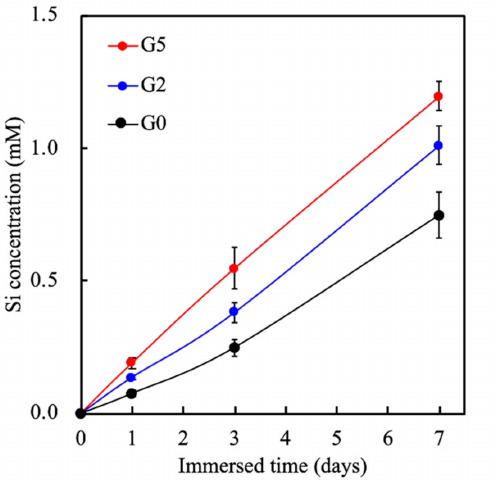
Figure 5. The Si ion concentrations in SBF after soaking for different durations. Data presented as mean ± SEM, n = 6 for each